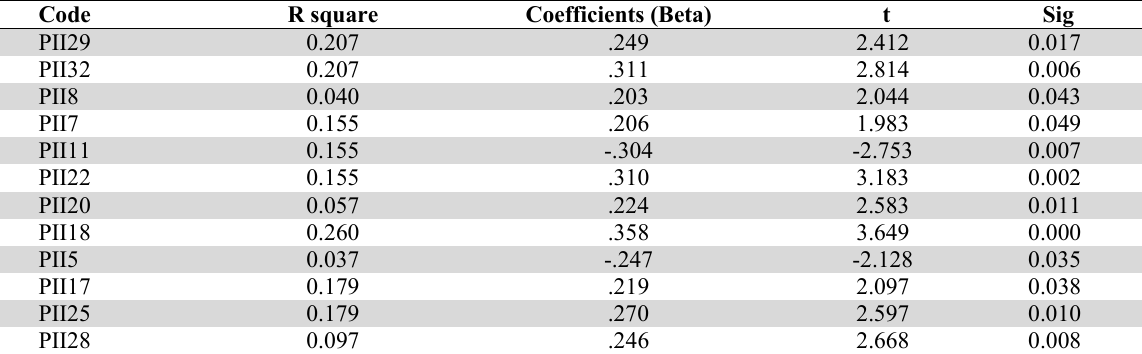
Summary result from regression model (Cost